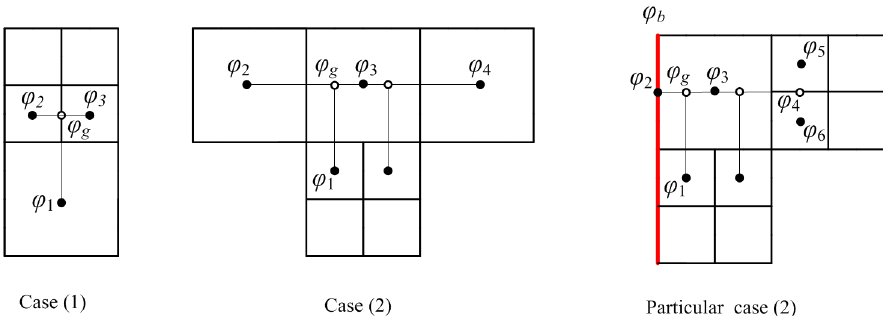
Figure 5. Two kinds of cases for hanging nodes (blank circle indicates ghost nodes).